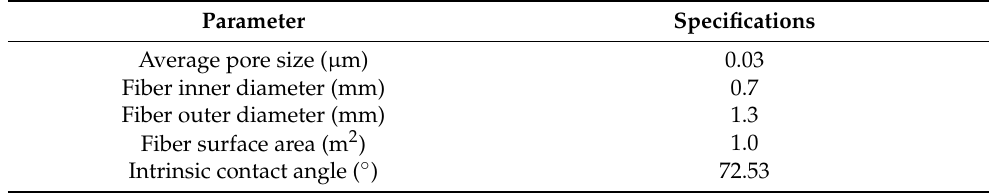
Table 1. Specifications of the commercial poly(vinylidene fluoride) (PVDF) hollow fiber membrane.